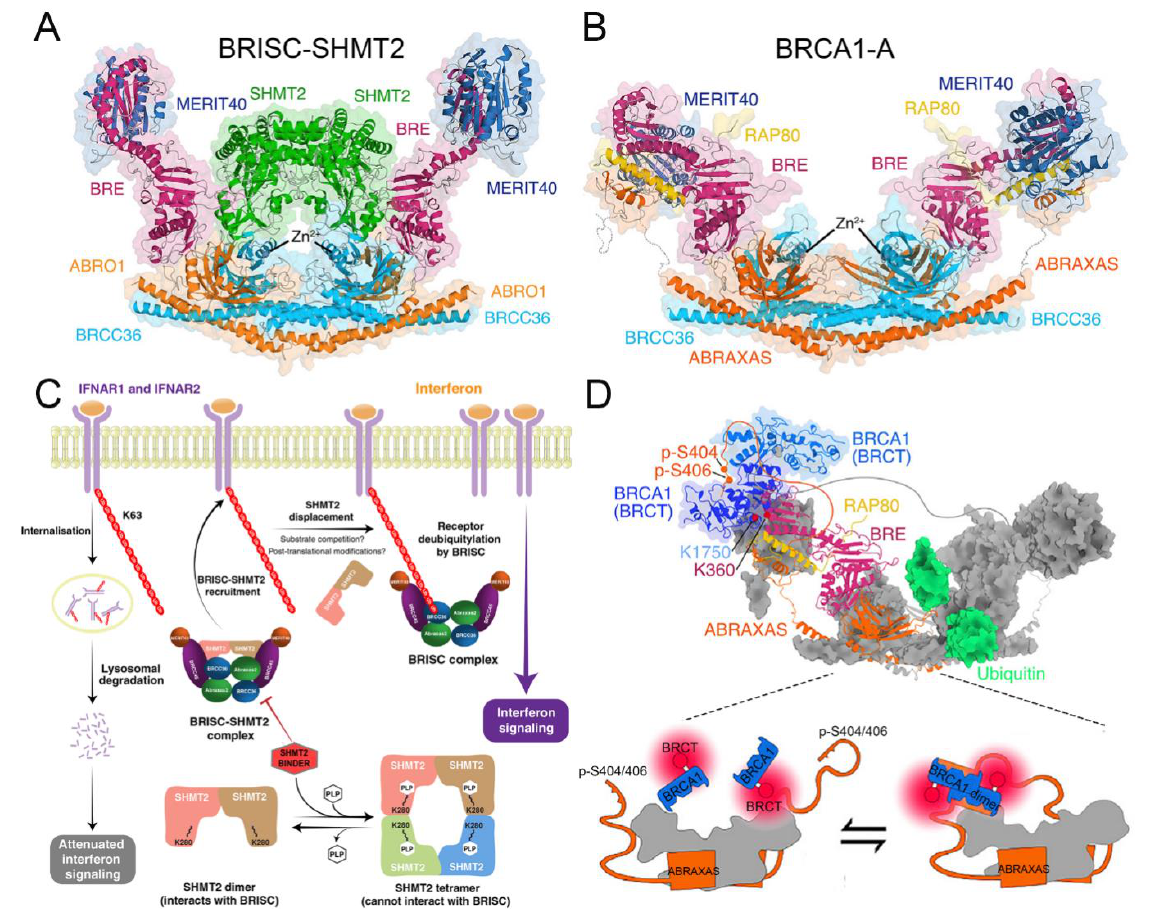
Figure 5. ( A ) Cryo-EM structure of the BRISC-SHMT2 complex (PDB ID: 6H3C). The BRCC45/BRE, MERIT40, BRCC36, Abro1/Abraxas2/KIAA0157, and SHMT2 are colored red, blue, cyan, orange, and green. ( B ) Cryo-EM structure of the BRCA1-A complex (PDB ID: 6GVW). The BRCC45/BRE, MERIT40, BRCC36, Abraxas, and RAP80 are colored red, blue, cyan, orange, and yellow. ( C ) Proposed model of BRISC-SHMT2 regulation of cytokine signaling using interferon as an example. The binding of PLP and SHMT2 regulates the BRISC–SHMT2 interaction and immune signaling in cell. Only the inactive SHMT2 dimer, but not the active PLP-bound tetramer, is able to bind and inhibit BRISC. ( D ) The model of the BRCA1-A-BRCA1 high-affinity complex. When DNA damage occurs, the S404 and S406 sites of Abraxas (orange) are doubly phosphorylated (p-S404/p-S406) and provide a high-affinity docking cradle for BRCA1 (blue), thereby inducing the formation of BRCA1 dimerization at the periphery of the BRCA1-A arc (gray). Panels A, B, D, and C are adapted with permission from [87,88], respectively. Copyright 2019 Elsevier, and copyright 2019 Springer Nature.